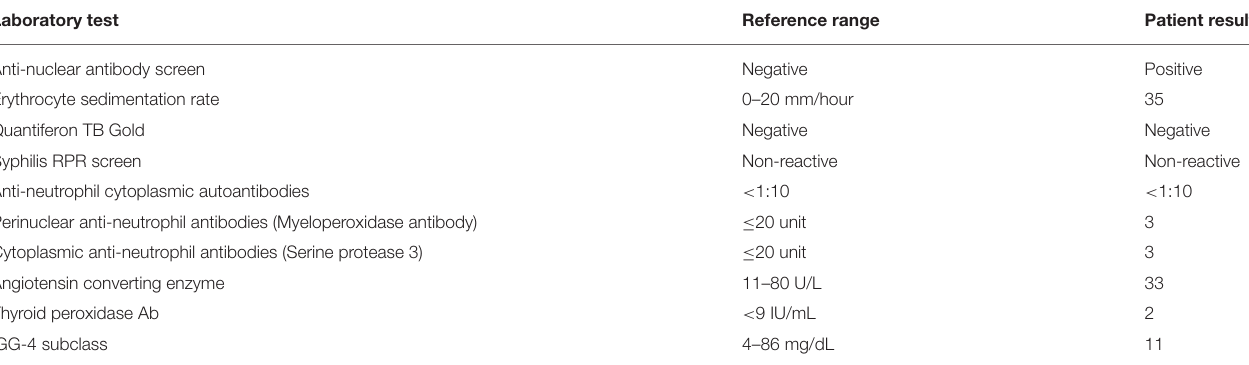
TABLE 1 | Laboratory evaluation for secondary causes of granulomatous